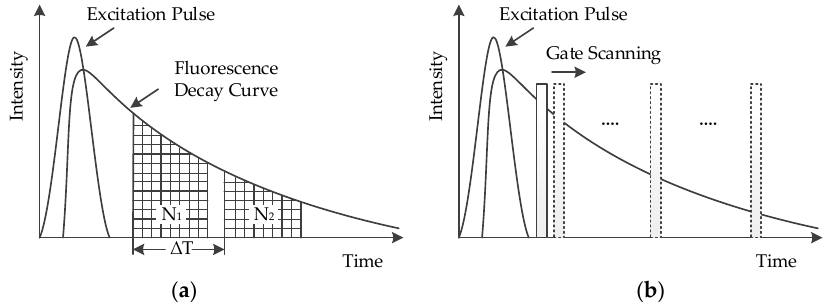
Figure 1. The two methods of time-gated fluorescence detection. ( a ) The fluorescence decay curve detected using two time gates with equal width; ( b ) the time gate scanning method.